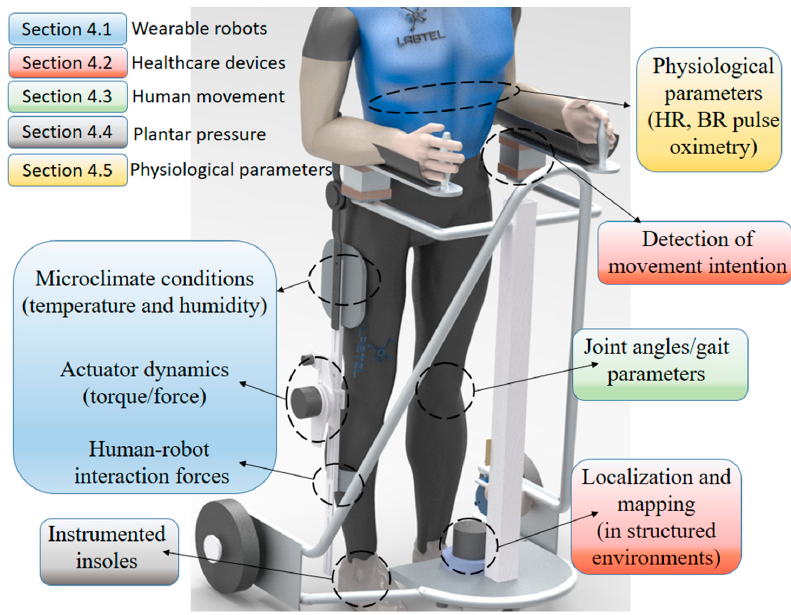
Figure 2. Wearable healthcare devices and parameters for POF sensor applications. The figure also indicates which section each application is in.